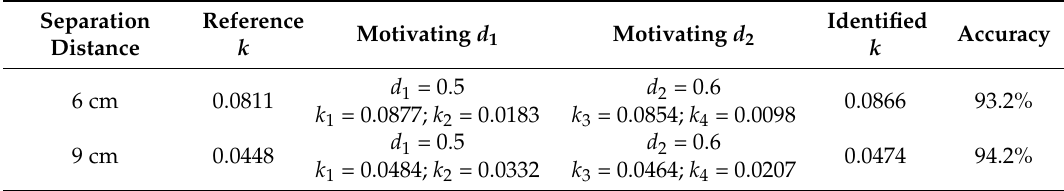
Table 3. Identification process and results of k .